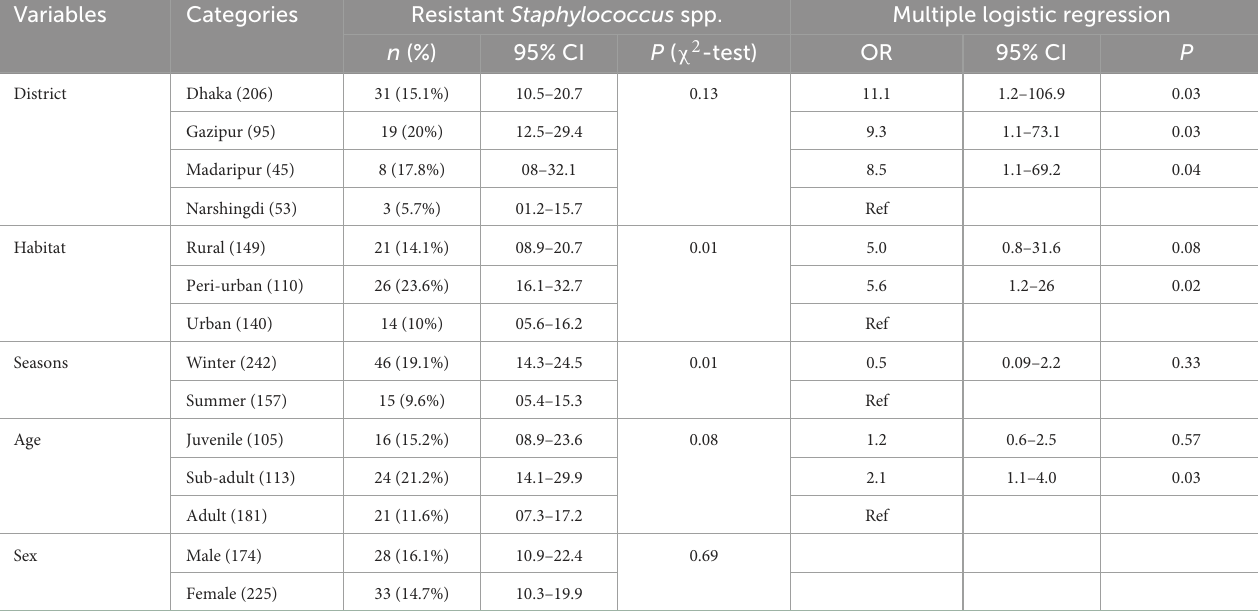
TABLE 3 Frequency distribution of resistant Staphylococcus spp. in rhesus macaque of Bangladesh.